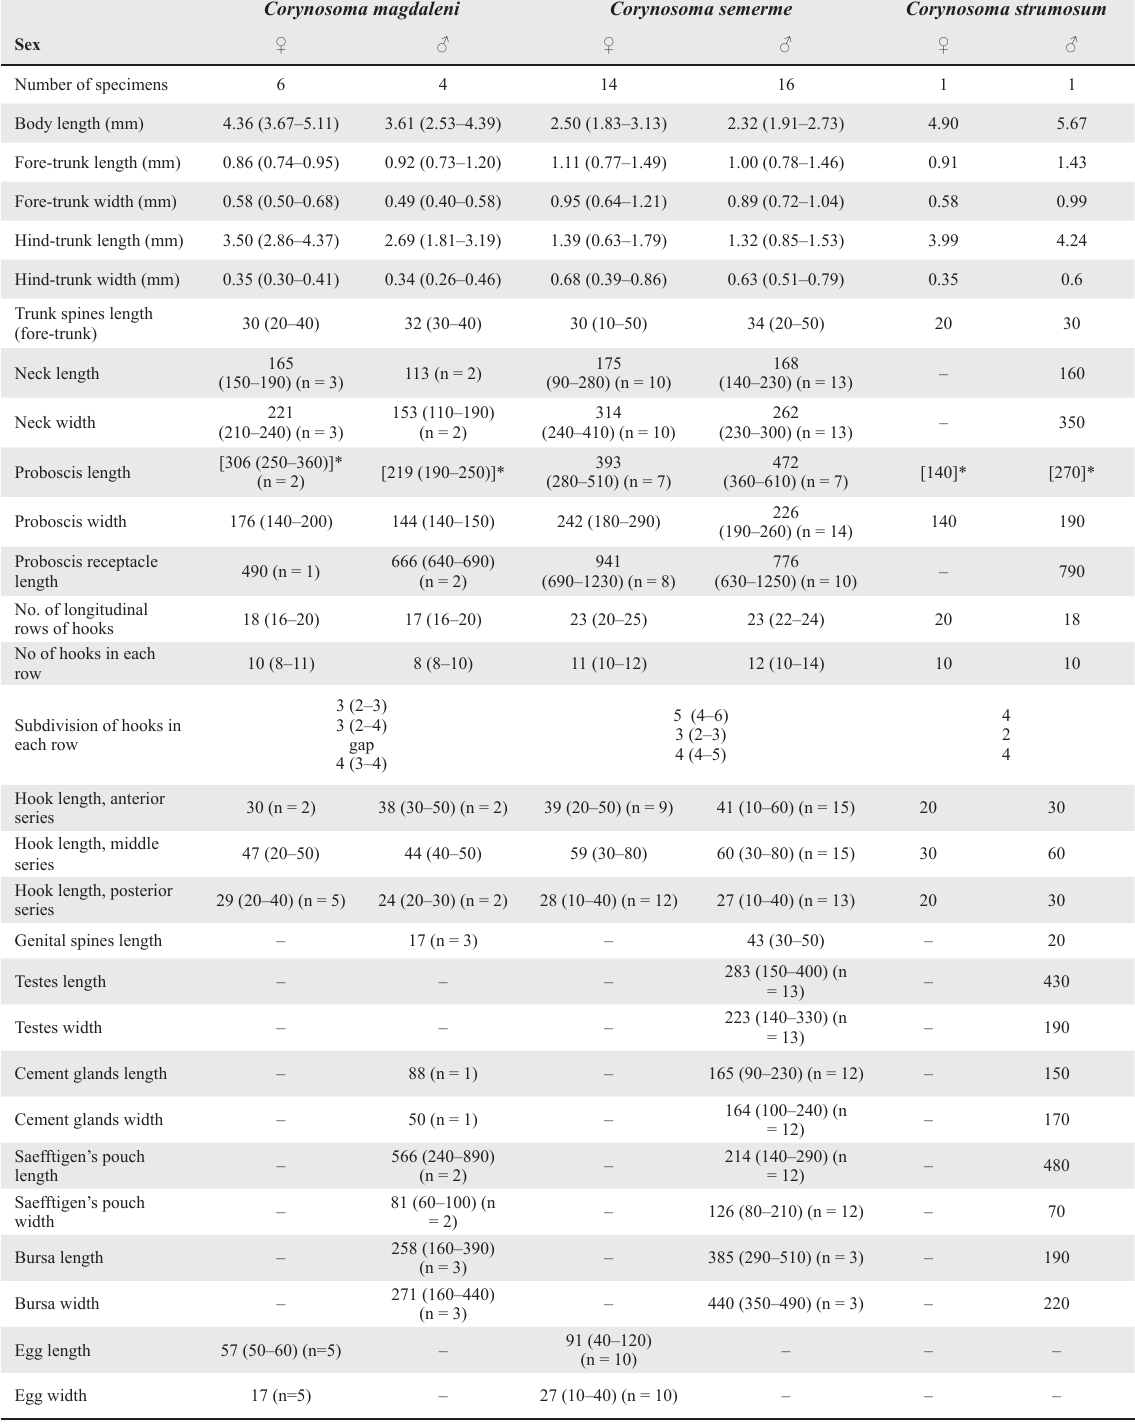
Table 2. Morphometric characters in Corynosoma magdaleni Montreuil, 1958 , C. semerme (Forsell, 1904) Lühe, 1911 and C. strumosum (Rudolphi, 1802) Lühe 1904 from grey seals, Halichoerus grypus , in the Baltic Sea presented as mean and (range). All measurements in micrometre (µm) unless otherwise noted. n = number of specimens measured is smaller than number of specimens available. * = proboscis not fully